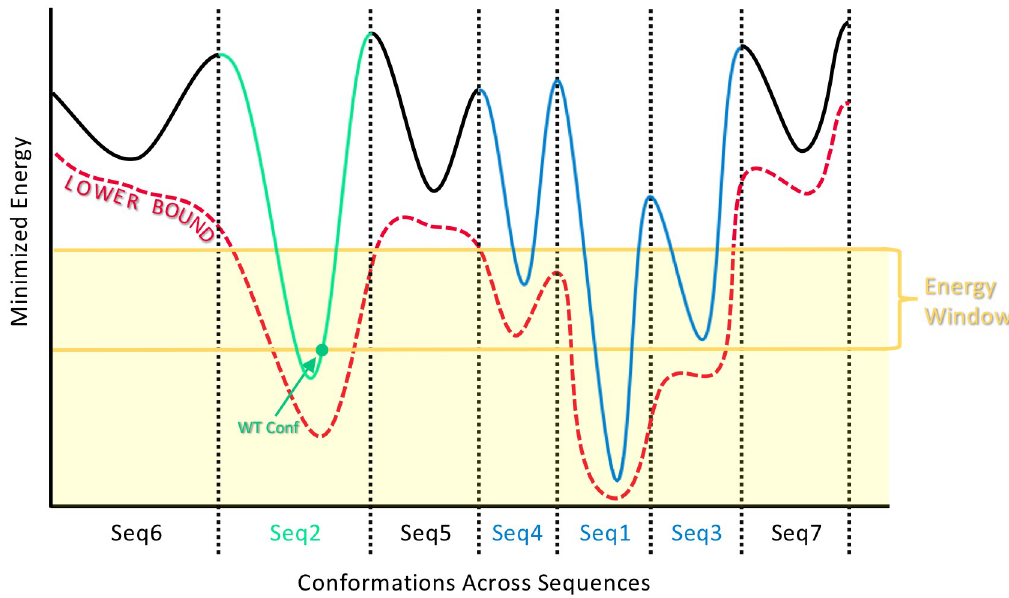
Fig 2. How FRIES chooses which sequences to keep and which sequences to prune. The solid curve represents the energy landscape of the conformation space that spans across, in this example, 7 different sequences (separated by dotted lines). Each sequence is labeled on the x -axis with an index indicating the order with which it is (or would be) enumerated with FRIES in order of increasing lower bound on minimized energy (red dotted curve). FRIES continues to enumerate in this way until it encounters the wild-type sequence (green), at which point FRIES calculates the minimized energy E WT of the conformation with the lowest lower bound on minimized energy for the wild-type sequence (marked with a green dot). E WT then becomes the baseline from which FRIES can provably enumerate all remaining sequences within some user-specified energy window w (yellow lines). Finally, FRIES prunes the sequences with energies provably higher than E WT + w (black) and keeps the sequences that occur within the shaded yellow region (colored in blue and green). More sequences are also pruned according to their partition function values as described in the Section entitled “Fast Removal of Inadequately Energied Sequences ( FRIES )” and Eq